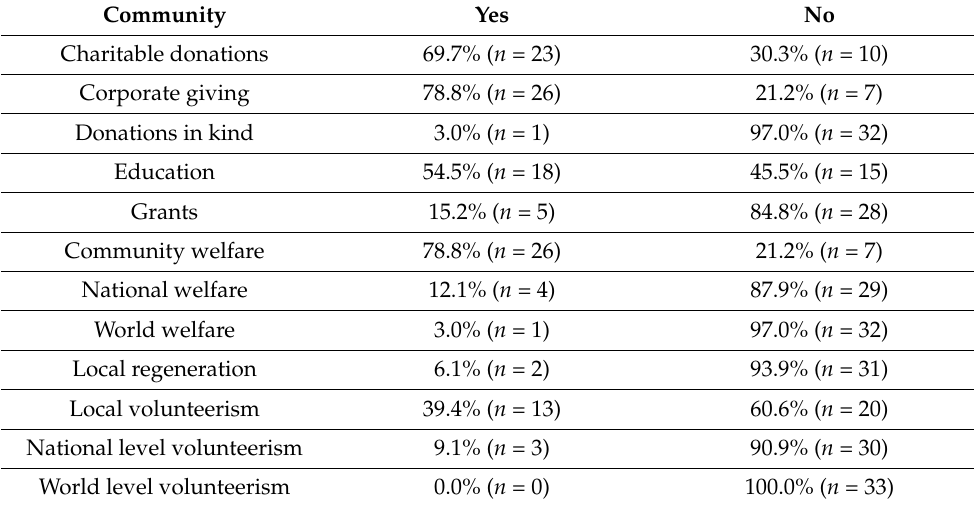
Table 5. Aspects of CSR activities: community.